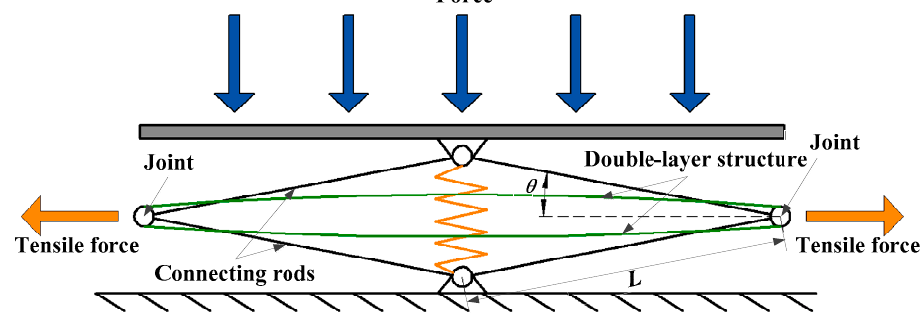
Figure 1. Two-dimensional sketch of the force amplification mechanism.